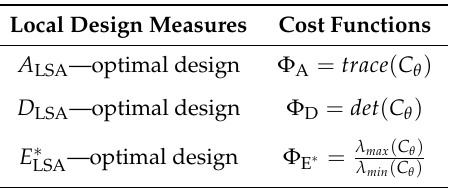
Table 3. Local design measures for MB-OED based on the parameter covariance matrix , where E ∗ refers to the modified E